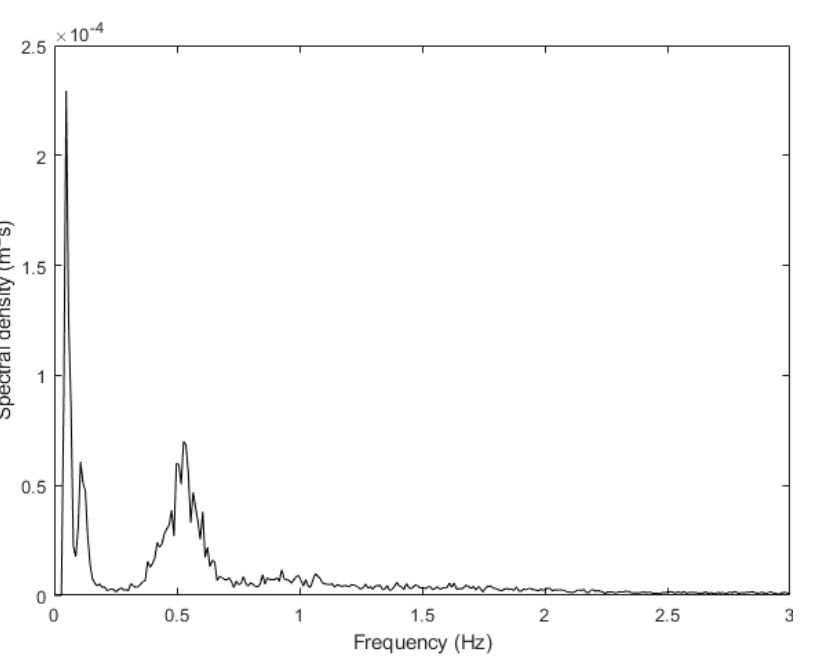
Figure 9. Example of wave spectrum for incident wave conditions at the dike toe (values in model scale).